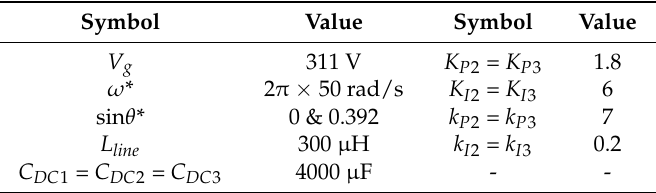
Table 1. Simulation Parameters.